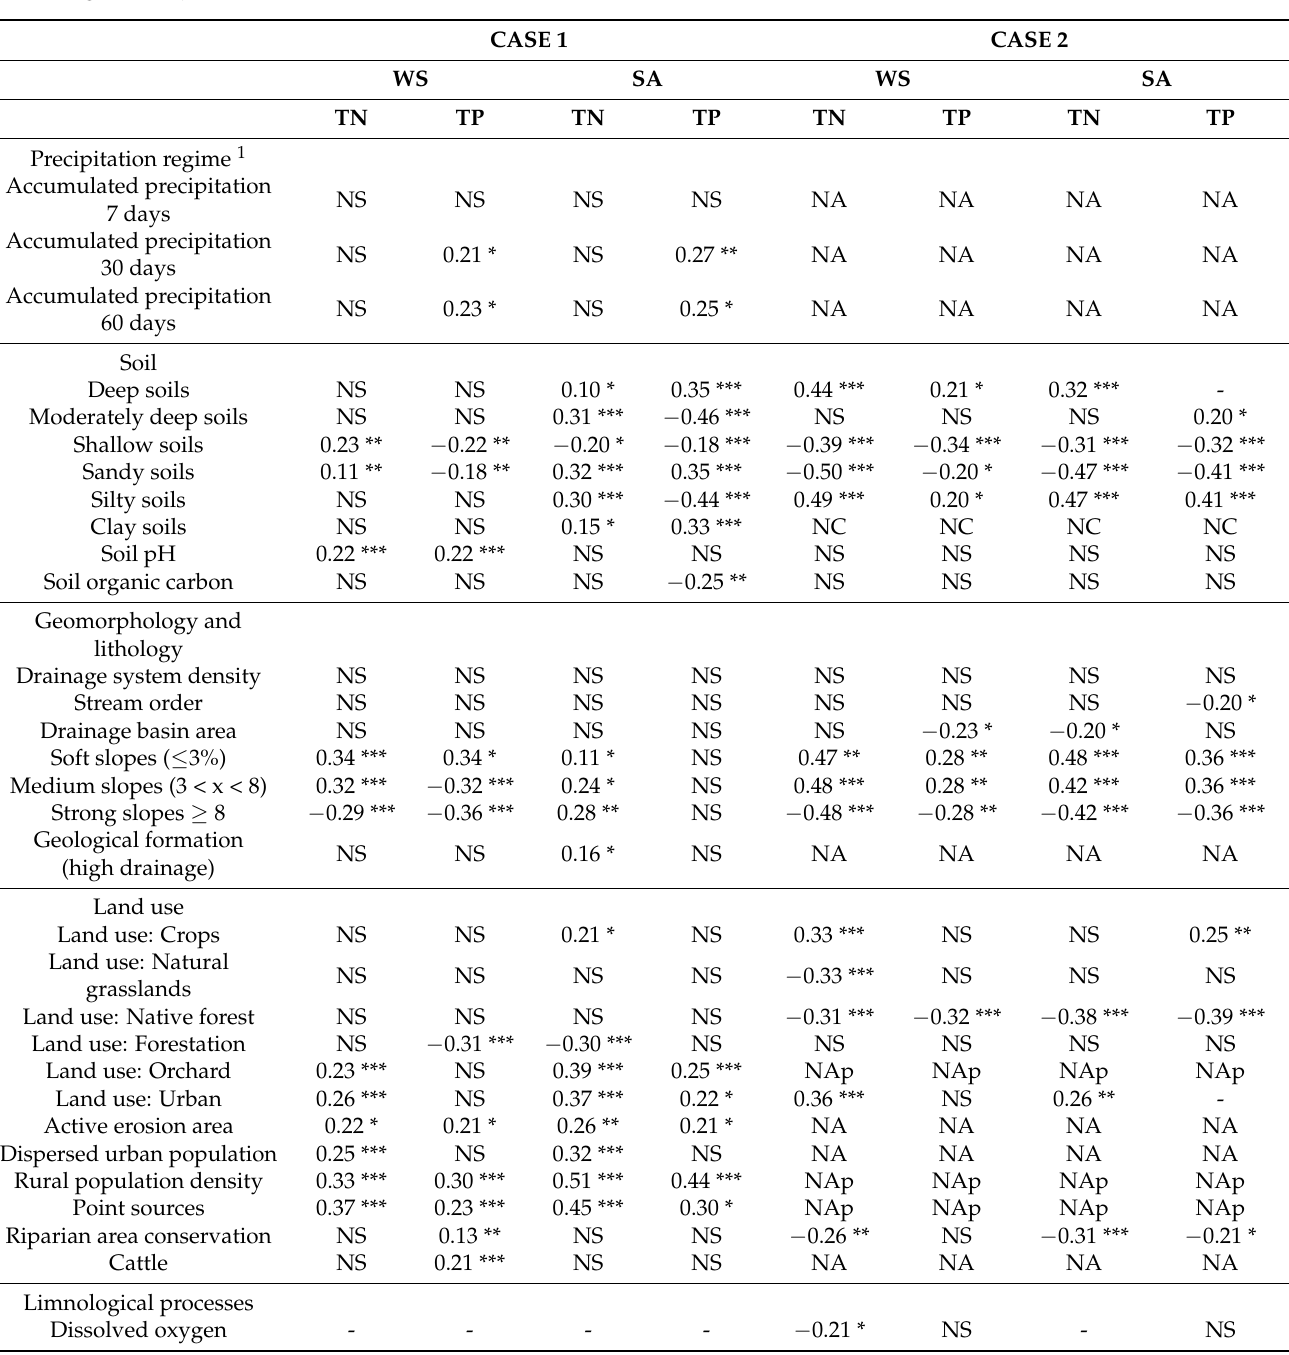
Table 3. Spearman’s rank correlation coefficient ( ρ ) between geophysical and land-use attributes, total nitrogen (TN, µ g/L) and total phosphorus (TP, µ g/L). Results of Cases 1 and 2 were included, showing winter–spring (WS) and summer–autumn (SA) sampling. NS: non-significant, NA: not analyzed, Nap: Not applicable *: significant p < 0.05), ** significant, p < 0.01), *** significant, p <